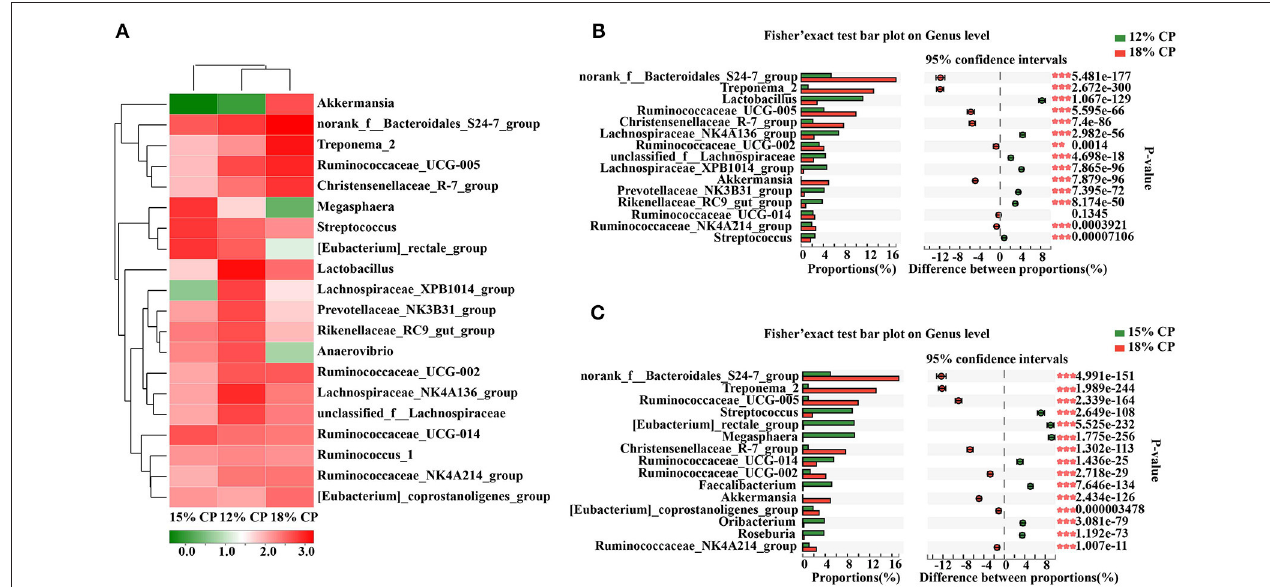
FIGURE 4 | Effects of low-protein diets on the composition of colonic microbiota in growing pigs at the genus level. (A) Distribution of the top 20 colonic bacteria at the genus level. (B) Fisher’ exact test bar plot on the genus level between the top 15 colonic bacteria of the 12 and 18% CP groups. (C) Fisher’ exact test bar plot on the genus level between the top 15 colonic bacteria of the 15 and 18% CP groups.